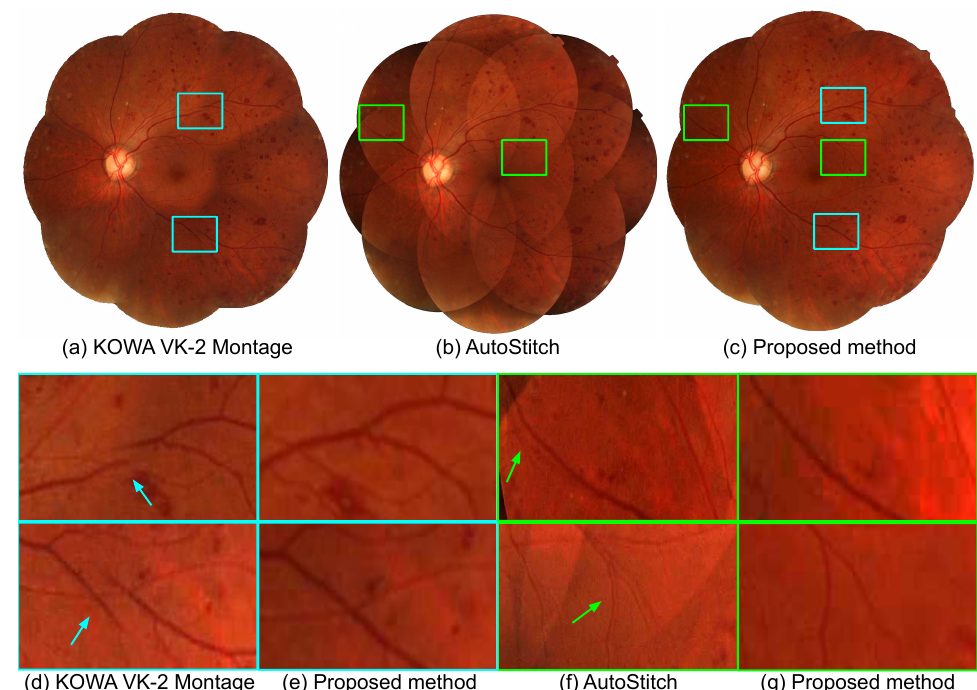
Figure 7. Retinal photomontages constructed by ( a ) the montage function of KOWA VK-2 [29], ( b ) AutoStitch [30], and ( c ) the proposed method, respectively. Local regions highlighted as boxes in ( a – c ) are enlarged in ( d – g ). ( d ) and ( f ) show the comparison between KOWA VK-2 montage and the proposed method, and ( e , g ) show the comparison between AutoStitch and the proposed method,